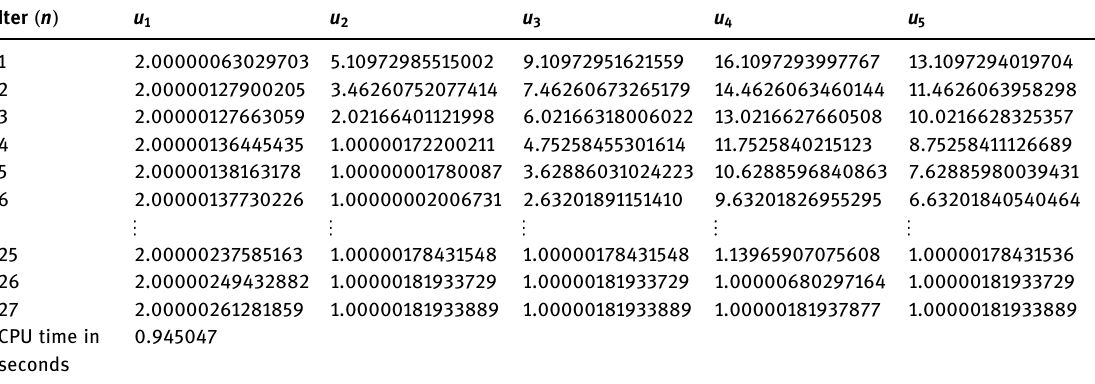
Table 1: Example 5.2: Numerical study of Algorithm 1 in [ 28 ] with TOL = 10 −4 and u